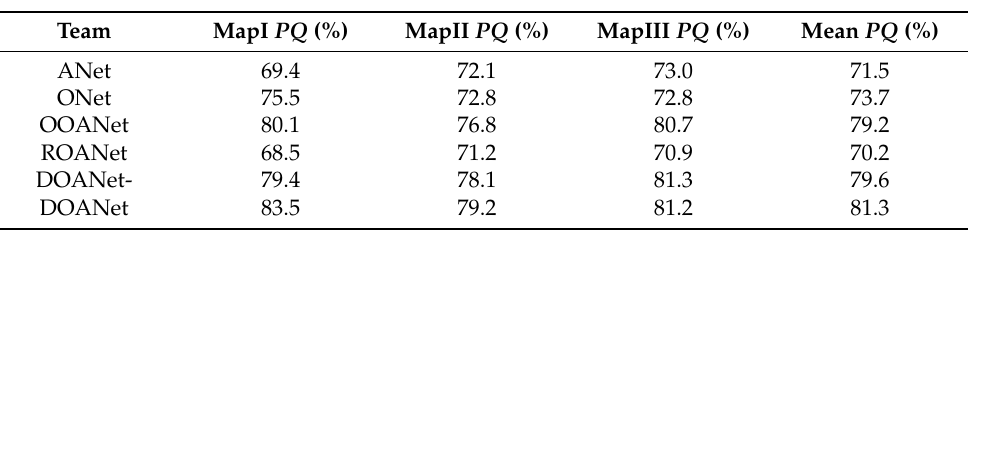
Table 2. Evaluation results of DOANet with varying network configurations.